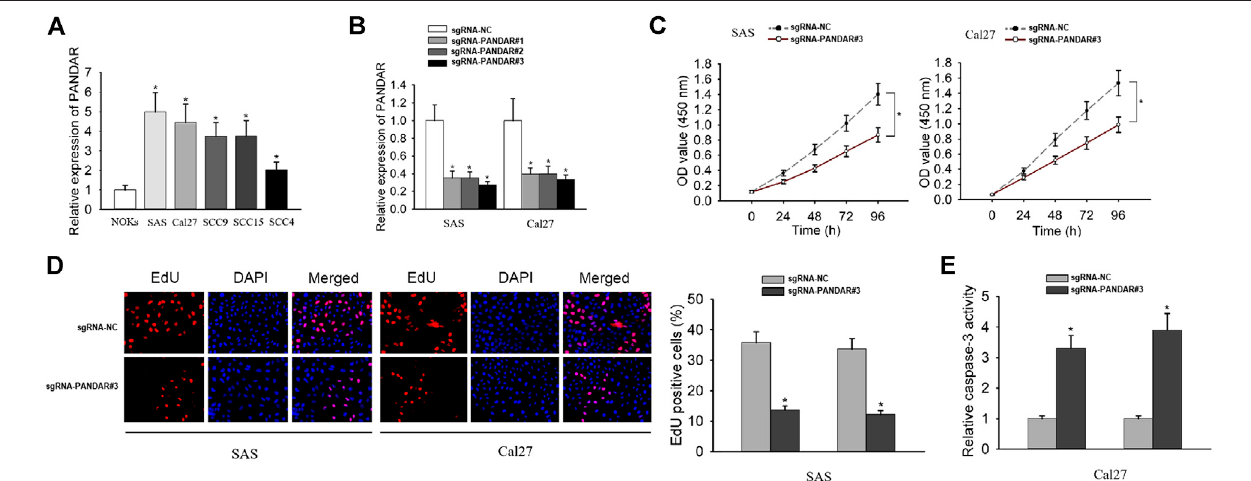
FIGURE 1 | The impact of PANDAR knockdown on proliferation and apoptosis of OSCC cells. ( A) The relative expression level of PANDAR in cancerous cell lines andnormalcellline.( B) Theknockdownef fi ciencyofspeci fi csgRNAstargetingPANDARwasdetectedinOSCCcellsbyqRT-PCR.( C – E)